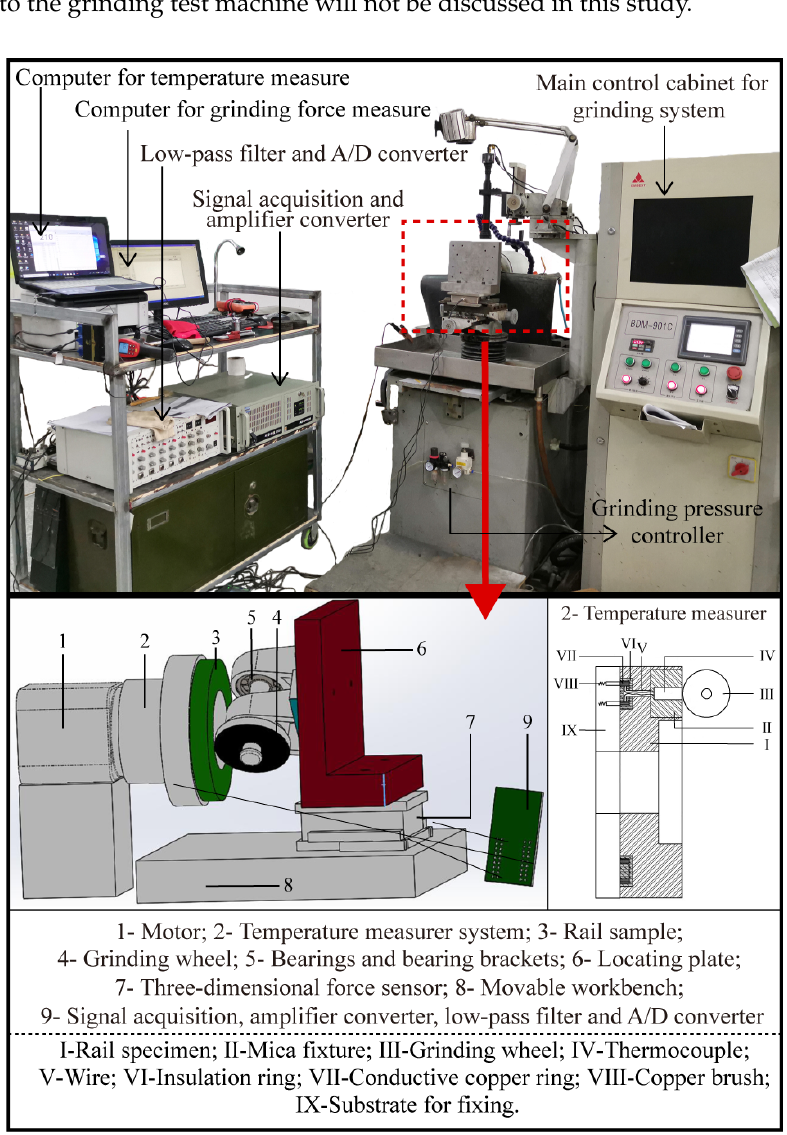
Figure 2. Structure of the grinding test machine.